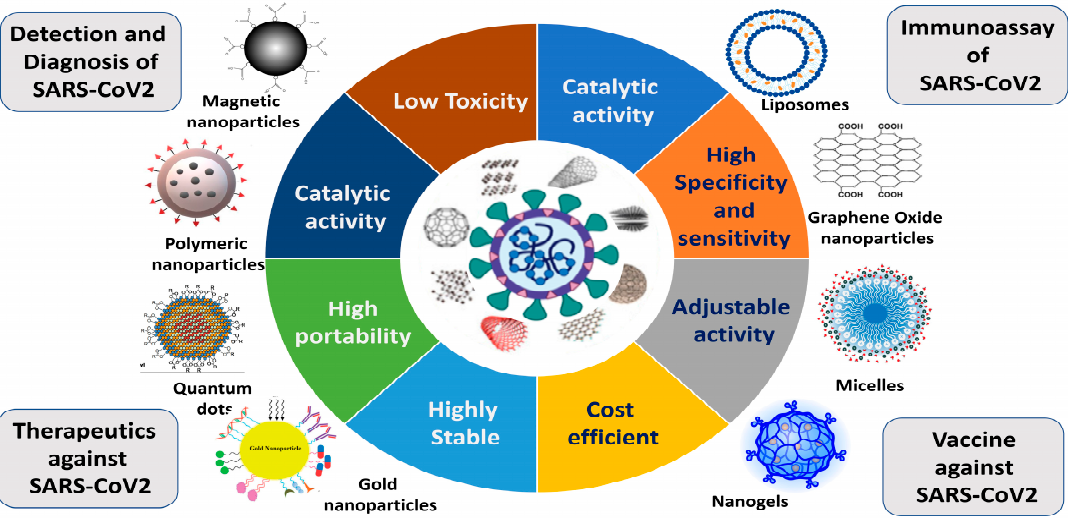
Figure 4. Applications of nanoparticles and the characteristics that make nanoparticles an ideal can-